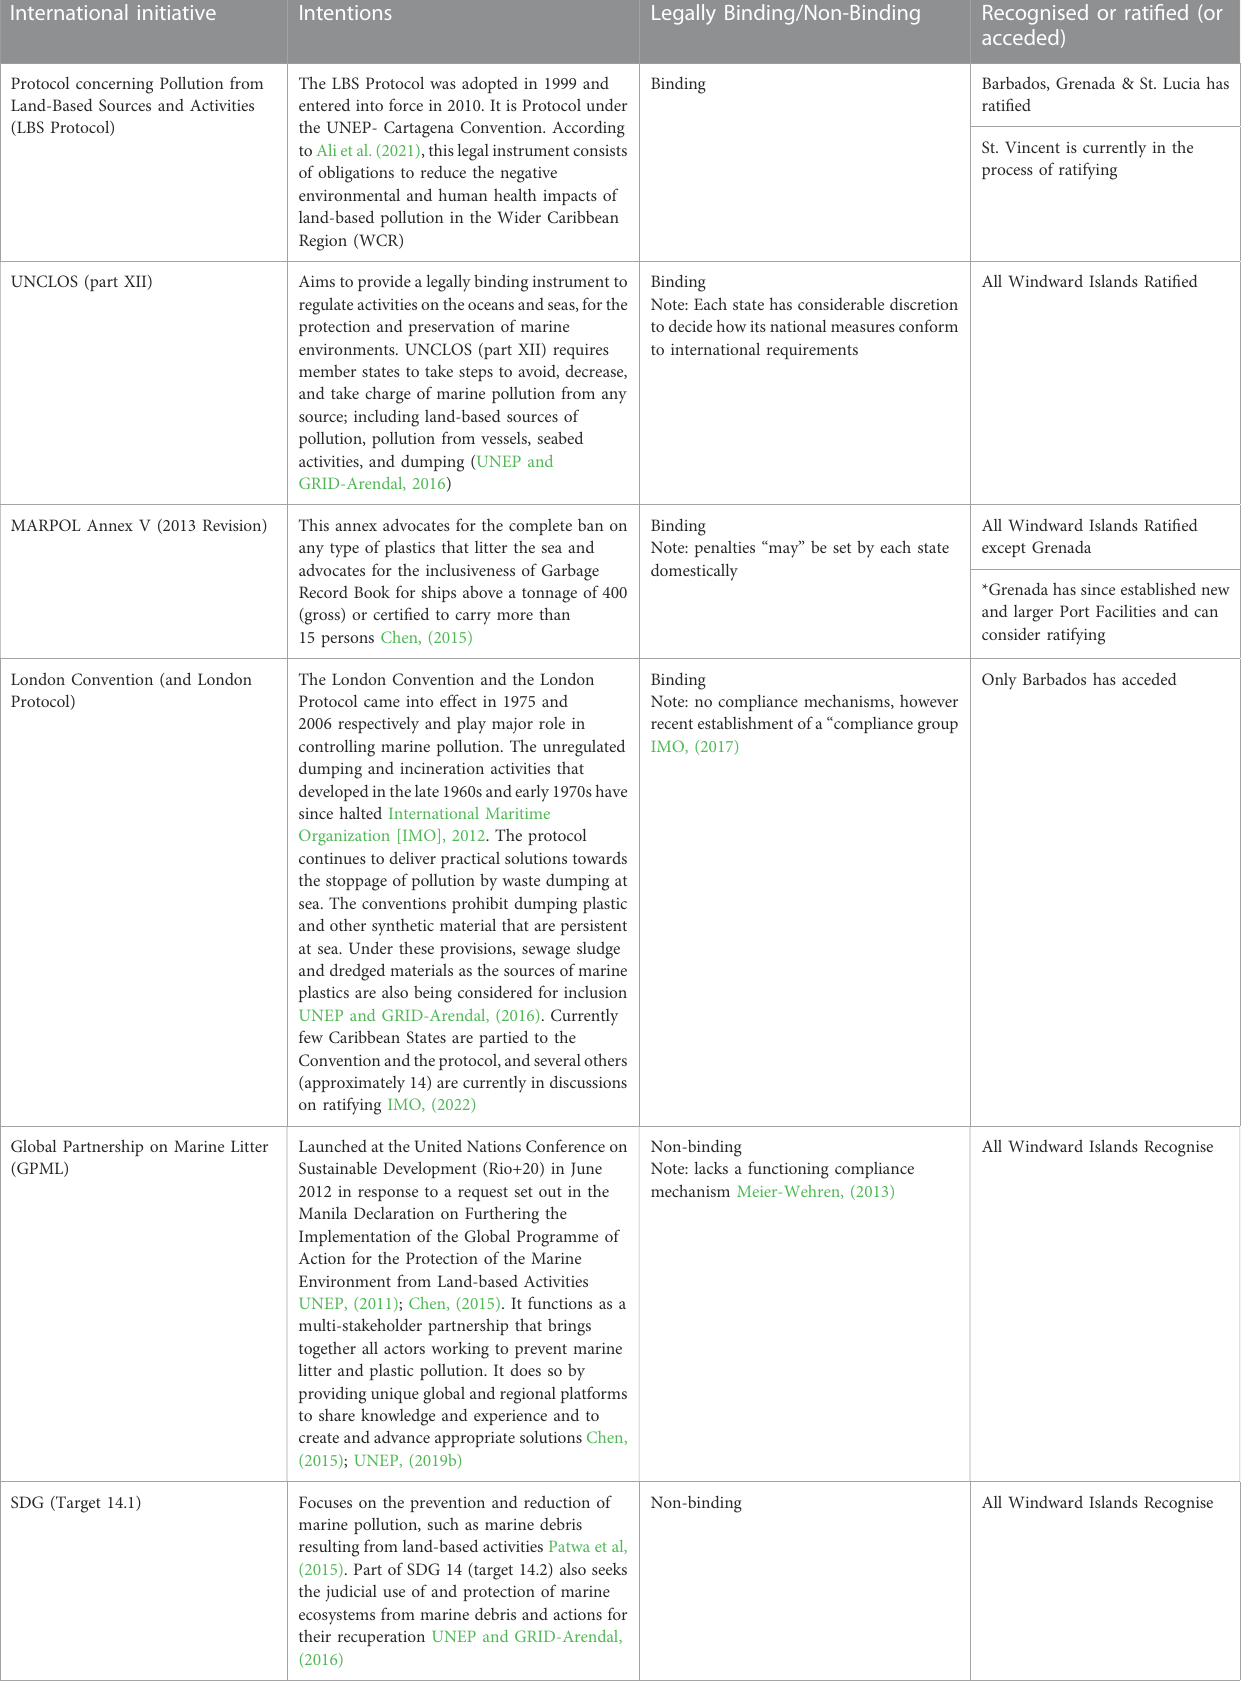
TABLE 4 International instruments most frequently acknowledged in the literature likely in fl uencing the Windward Islands journey to preventing and reducing marine litter. International initiative